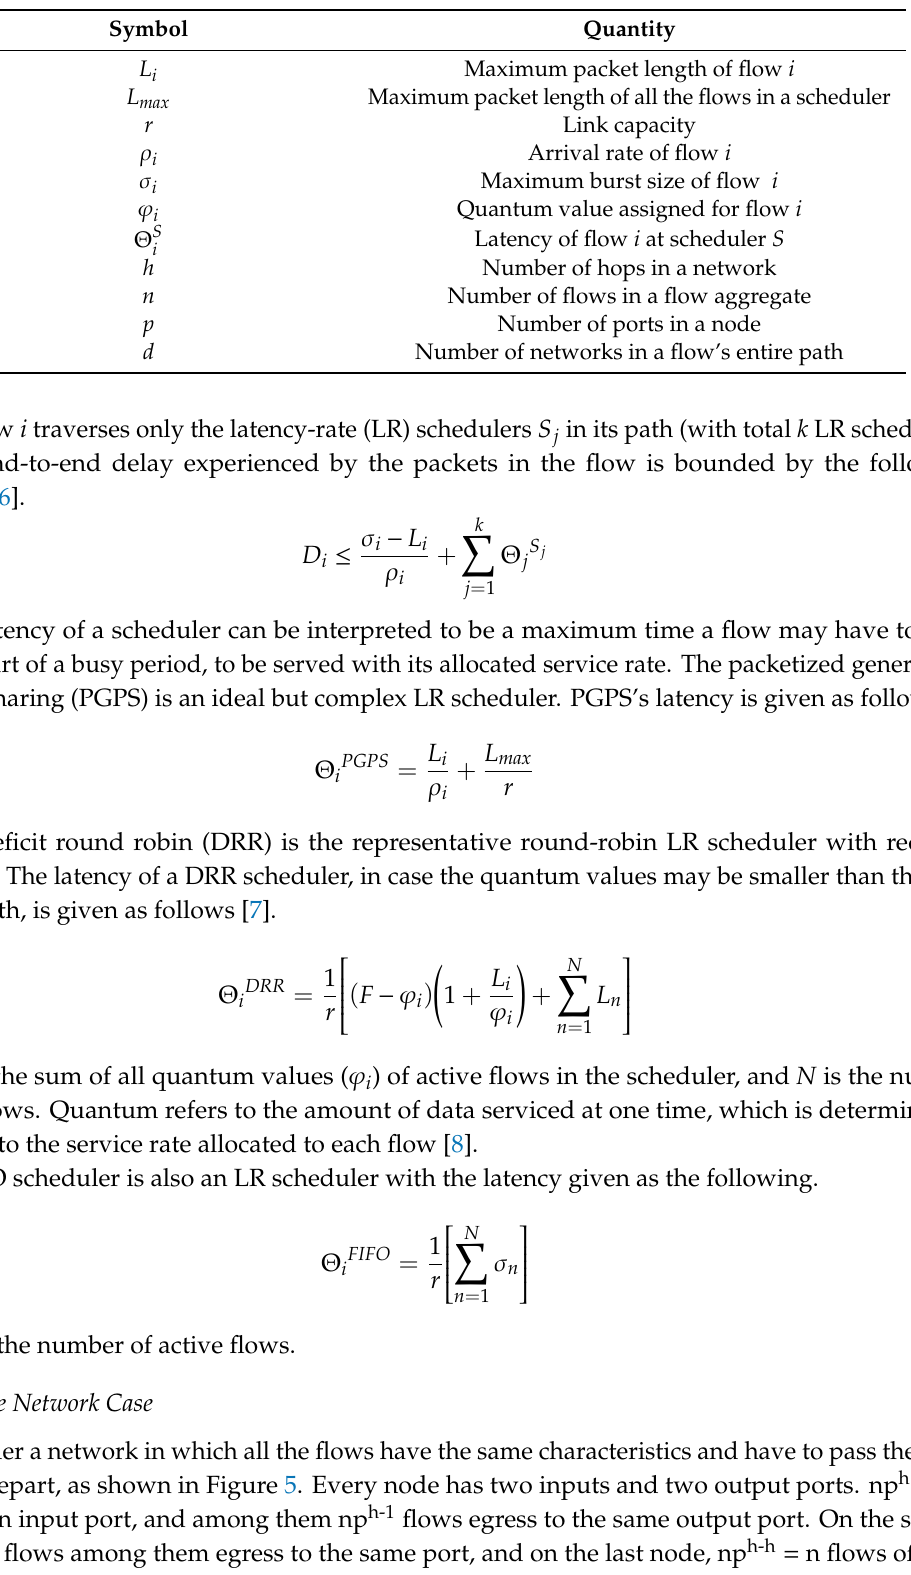
Table 1. Mathematical symbols used in this